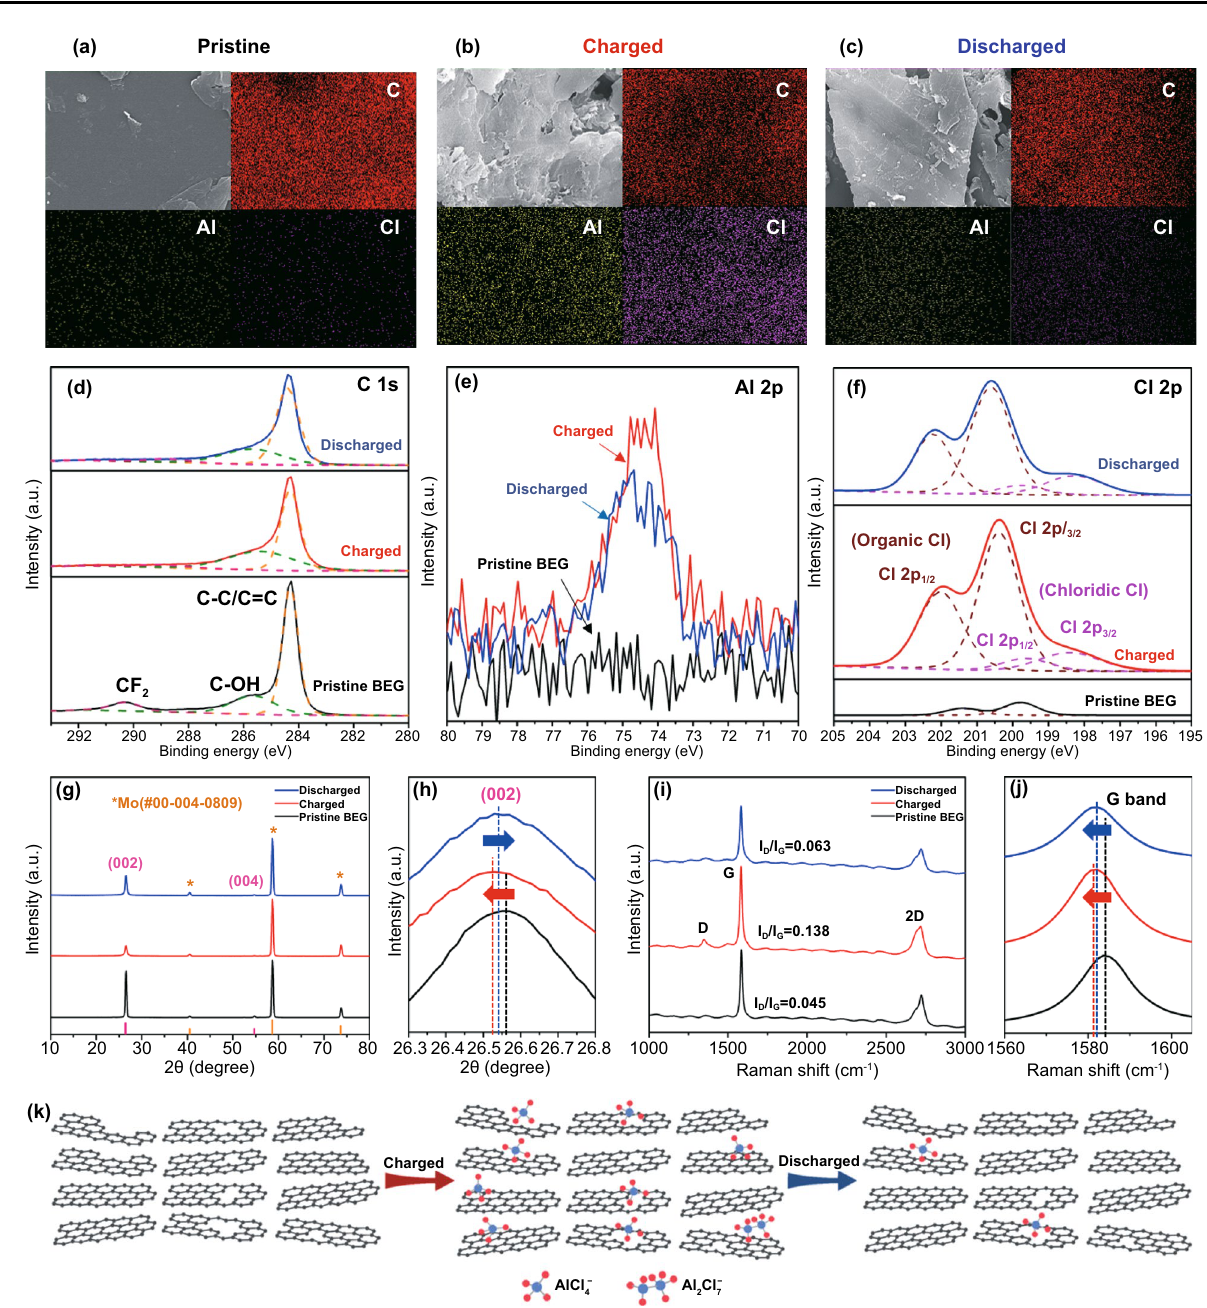
Fig. 8 SEM–EDX analysis of a pristine, b charged, and c discharged BEG electrode. The XPS profiles of d C Is, e Al 2p, and f Cl 2p signals, g XRD patterns, h the enlarged spectrum of (002) plane peaks for different states of BEG electrode. i Raman spectrum for different states of the pristine, charged, and discharged BEG electrode, and j the enlarged spectrum of the G band peaks for comparison. k Schematic diagram of the transportation of chloroaluminate anions into BEG electrode during charge–discharge